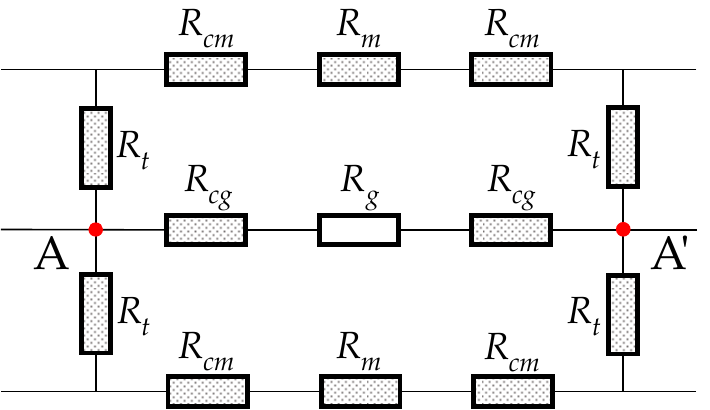
Figure 4. The magnetic circuit of the gap region.